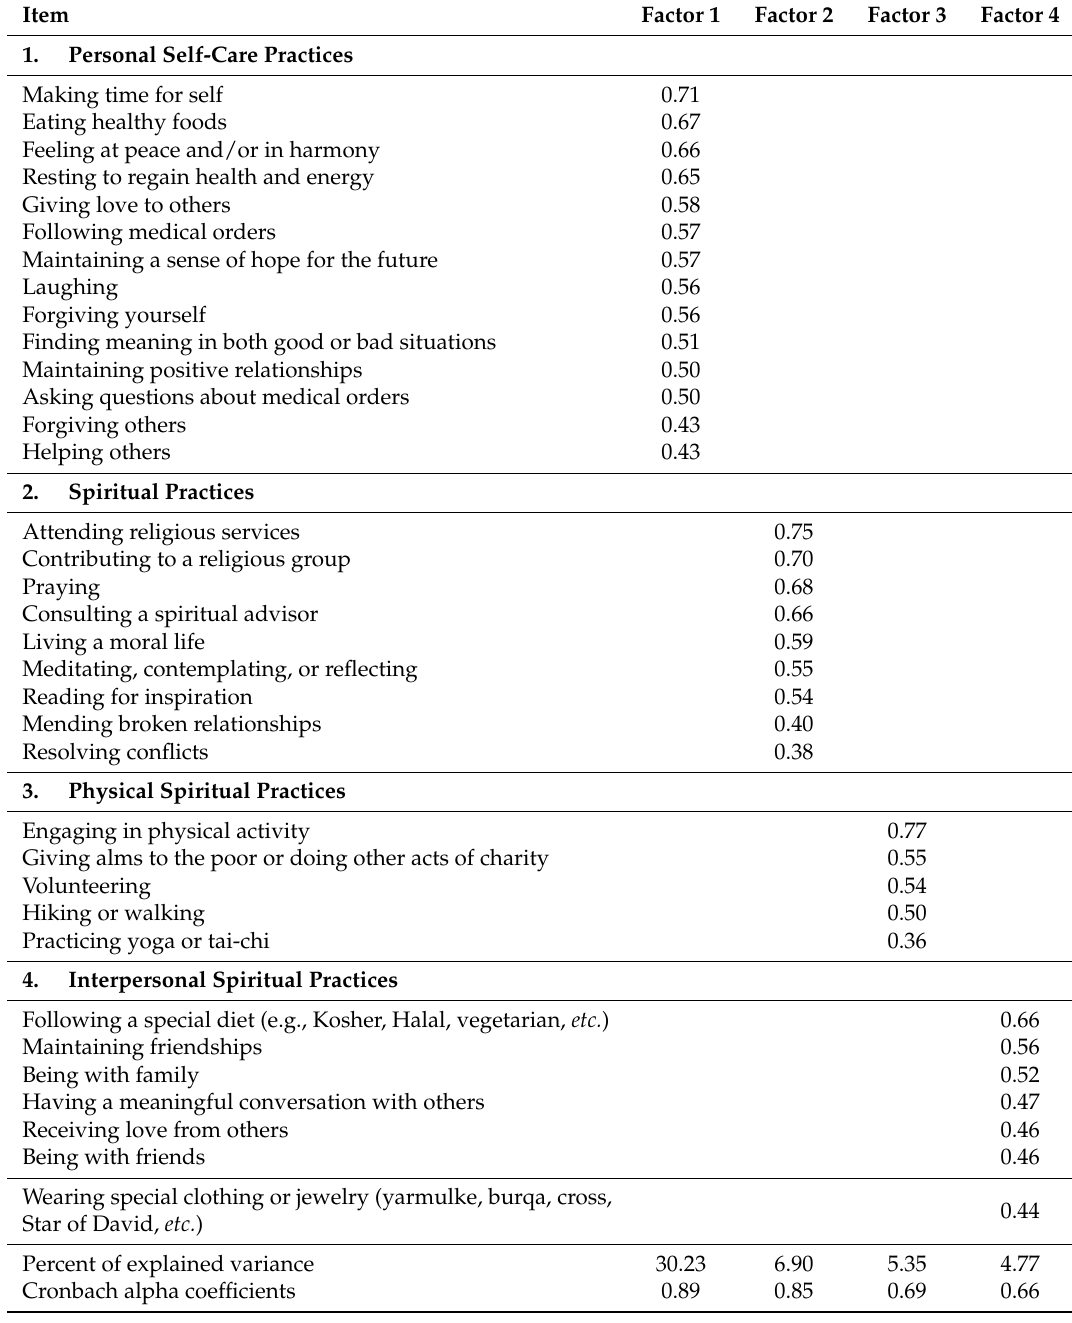
Table 2. Factor analysis of the spiritual self-care practices